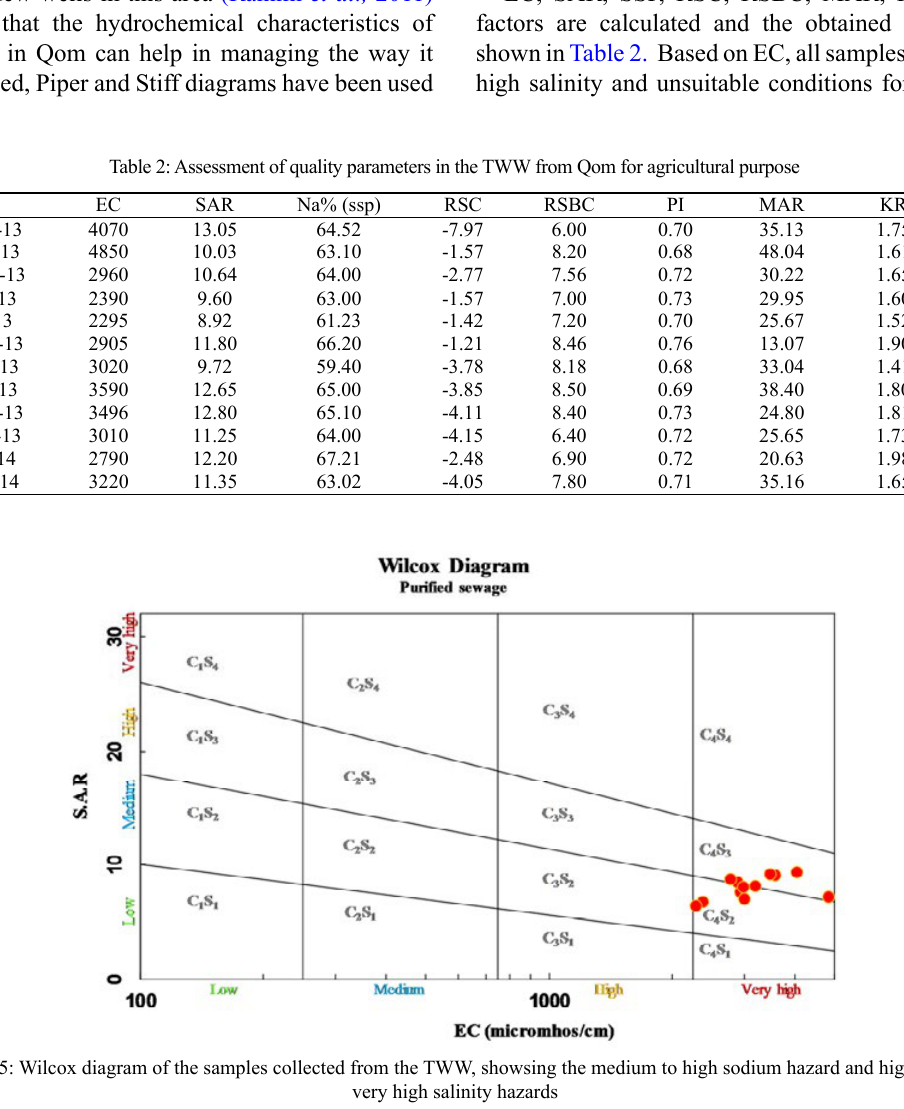
Table 2: Assessment of quality parameters in the TWW from Qom for agricultural purpose